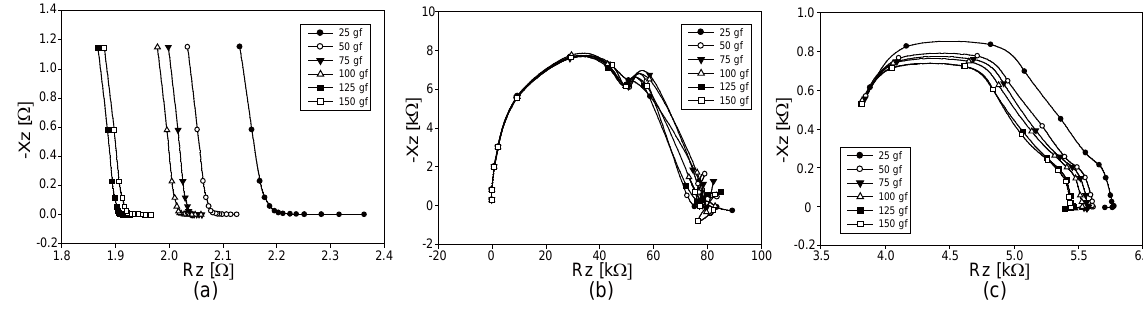
Figure 10. Argand diagrams of the impedance spectra from three conductive fabrics under compression. ( a ), ( b ), and ( c ) are from the fabrics A, B, and C, respectively.